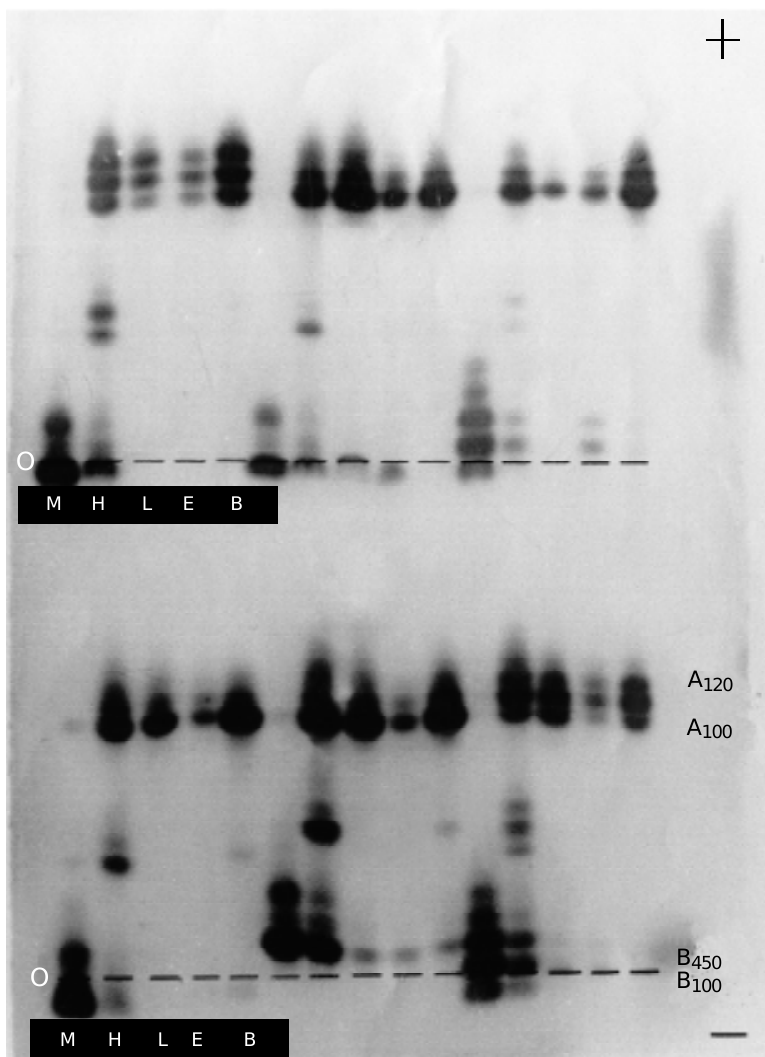
Figure 3 - Distribution of isozymes and allozymes of phosphoglucoisomerase (PGI) in muscle (M), heart (H), liver (L), eye (E), and brain (B) of C. macropterus specimens collected from the Solimões River, near Marchantaria Island (top), and from the Negro River, near Anavilhanas Archipelago (bottom). Four allelic forms were found in animals from both sites (A 100 , A 120 , B 100 , and B 450 ). O =